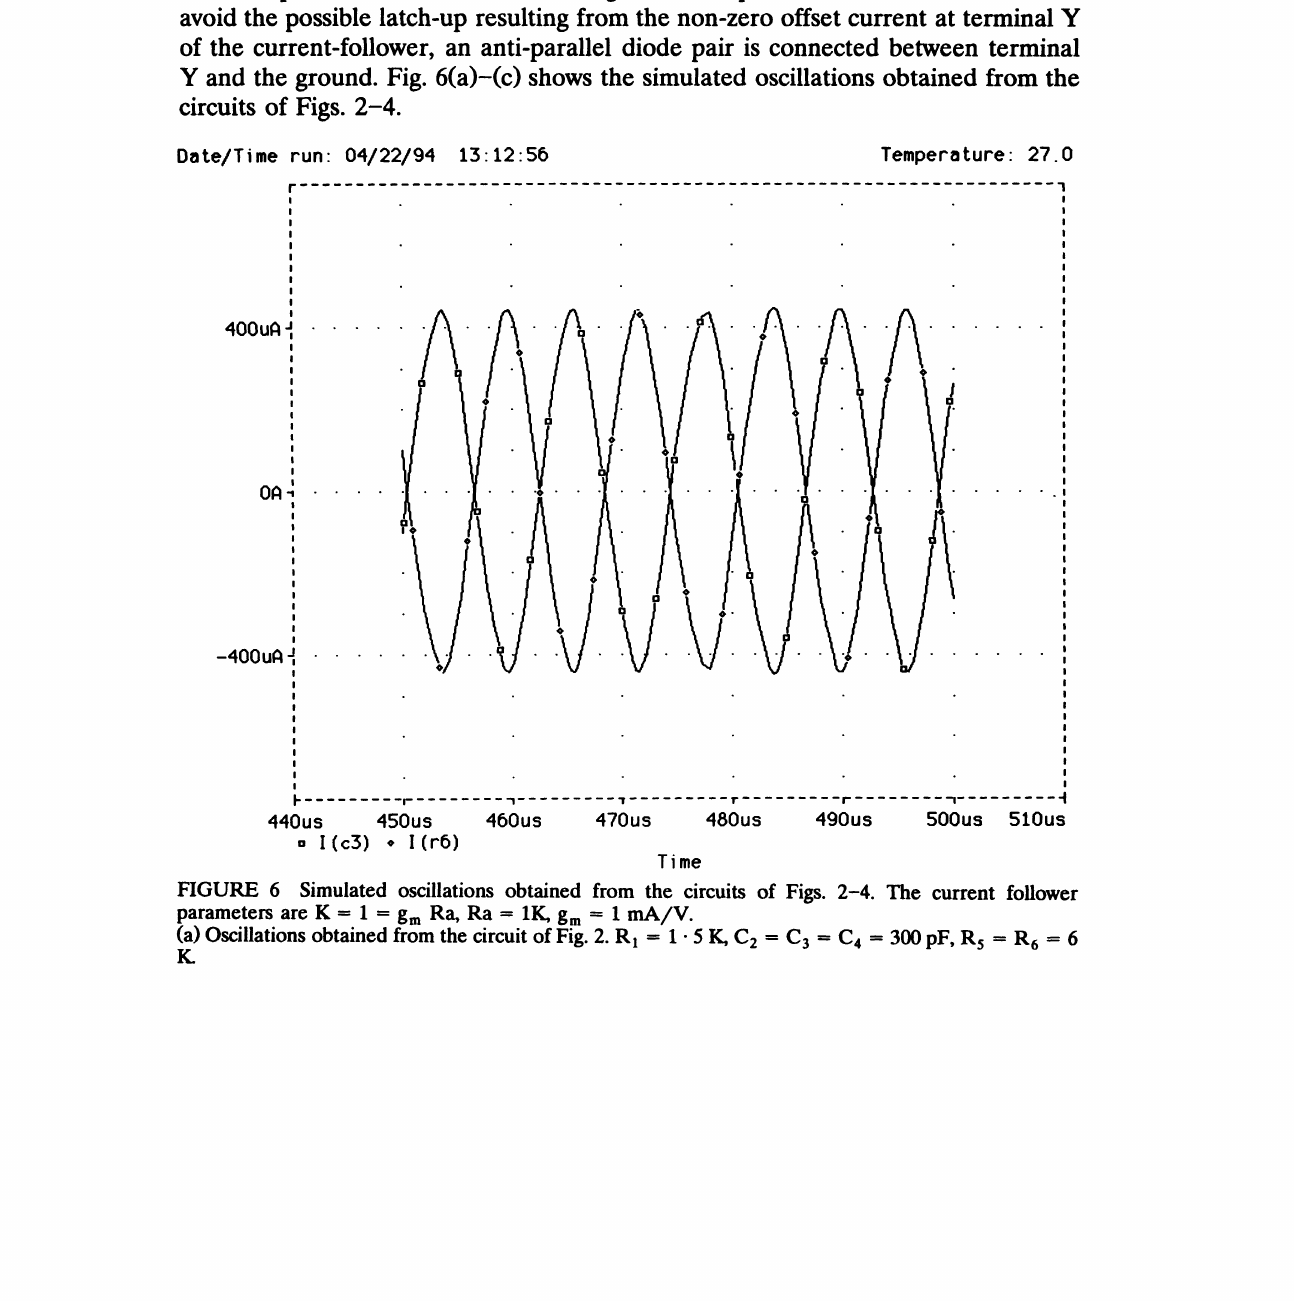
FIGURE 6 Simulated oscillations obtained from the circuits of Figs. 2-4. The current follower parameters are K gm Ra, Ra 1K, gm 1 mA/V. (a) Oscillations obtained from the circuit of Fig. 2. R 1 5 K,